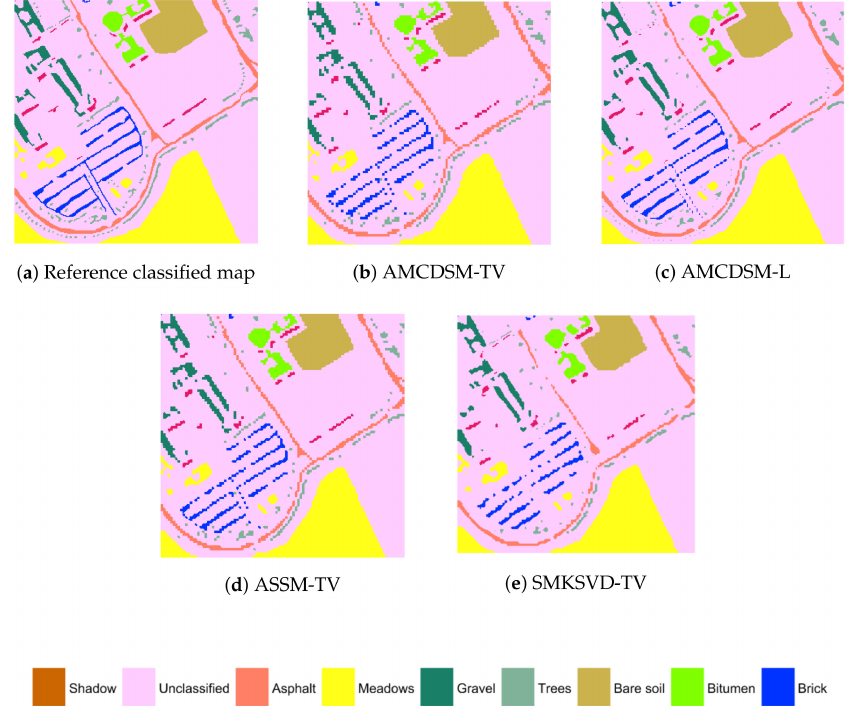
Figure 8. Sub-pixel mapping of Pavia university hyperspectral image.